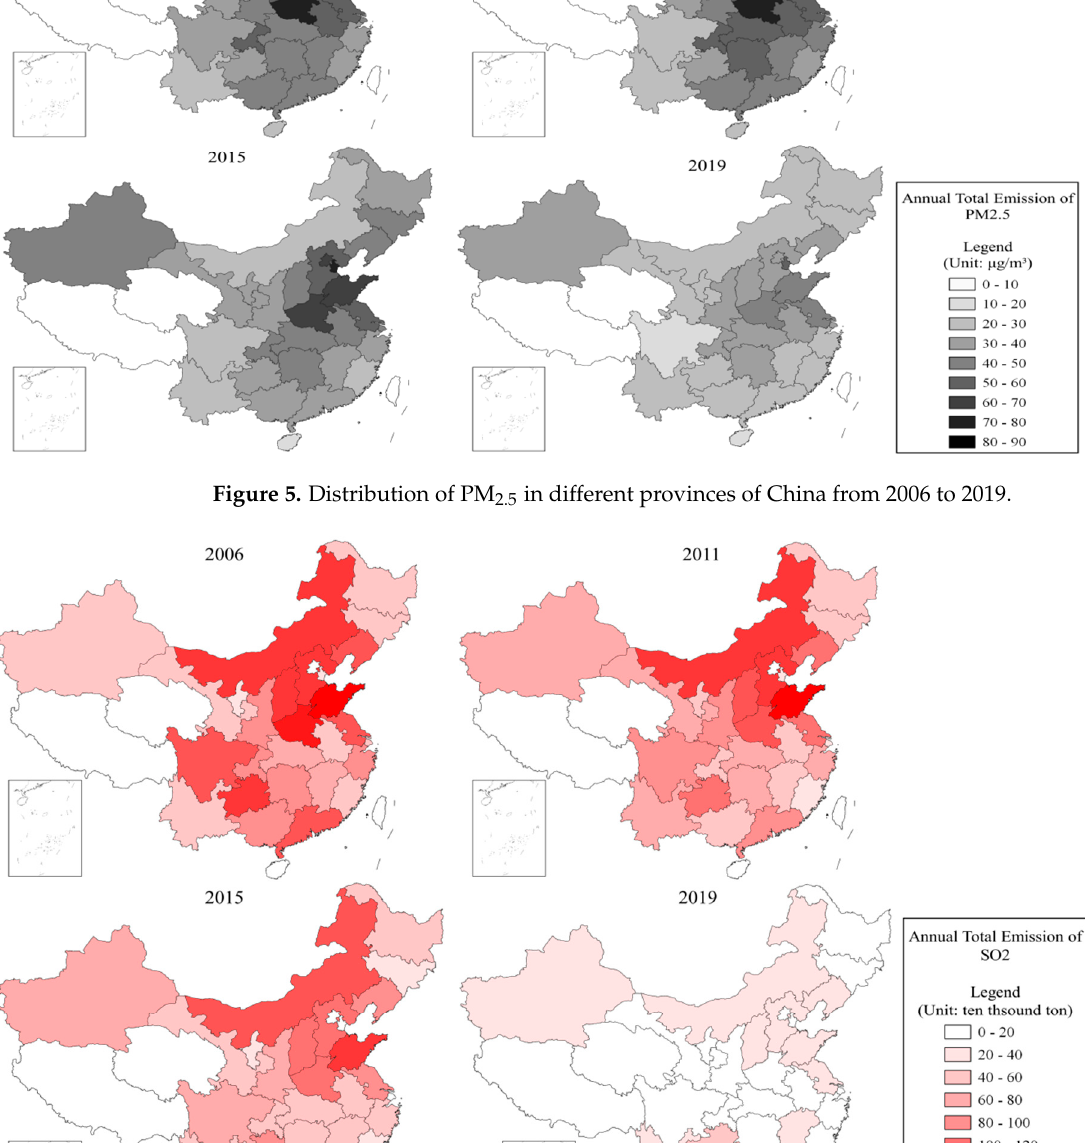
F igure 6. Distribution of SO 2 in Chinese provinces from 2006 to 2019.